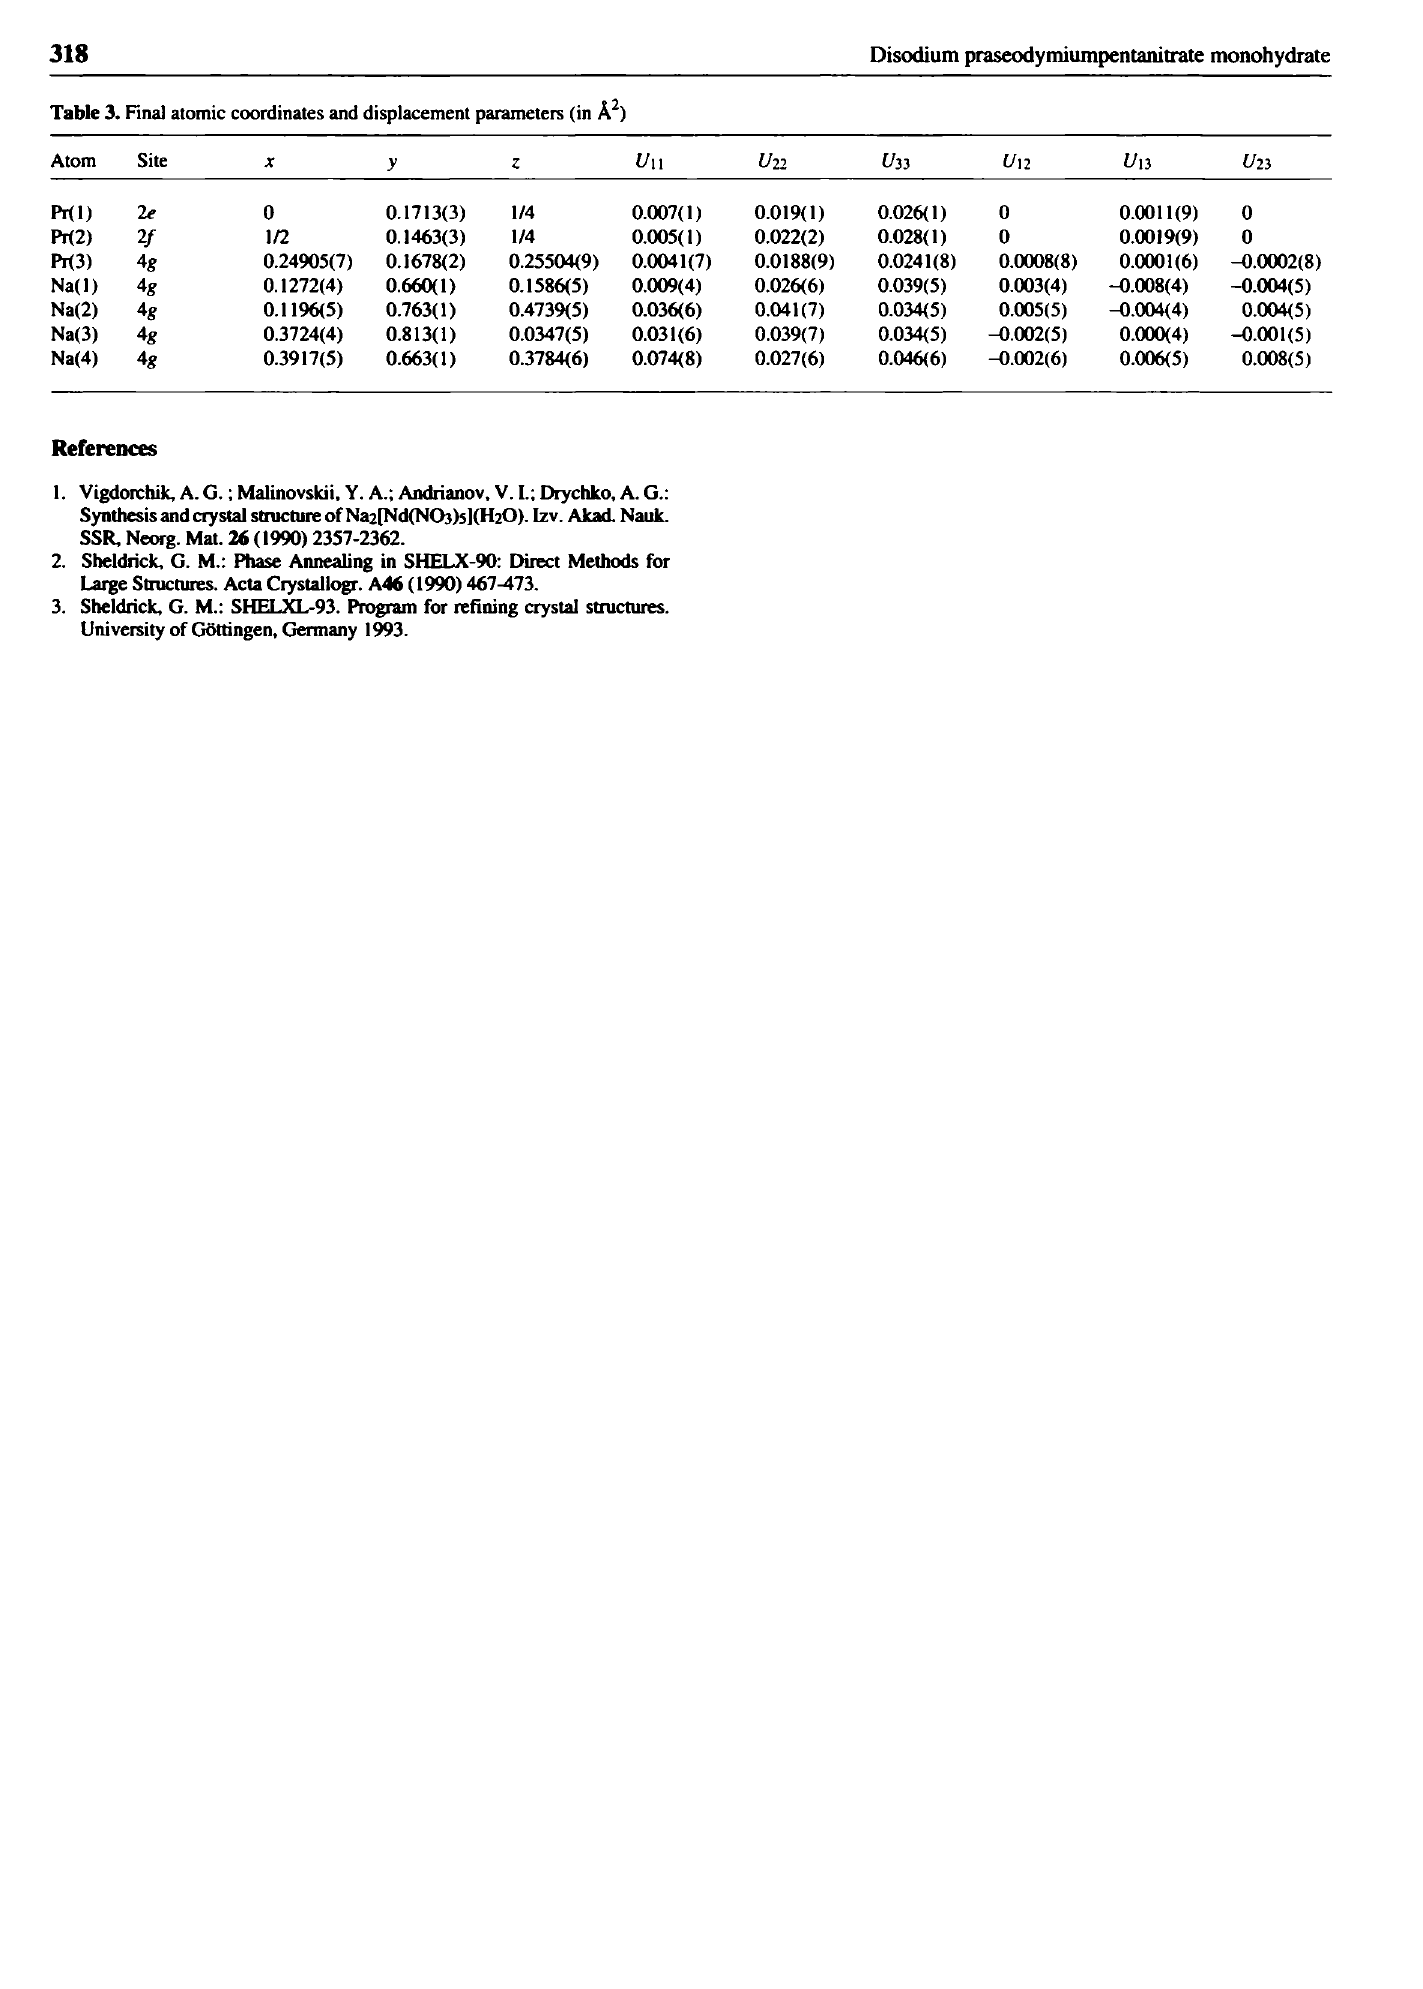
Table 3. Final atomic coordinates and displacement parameters (in Â 2 )